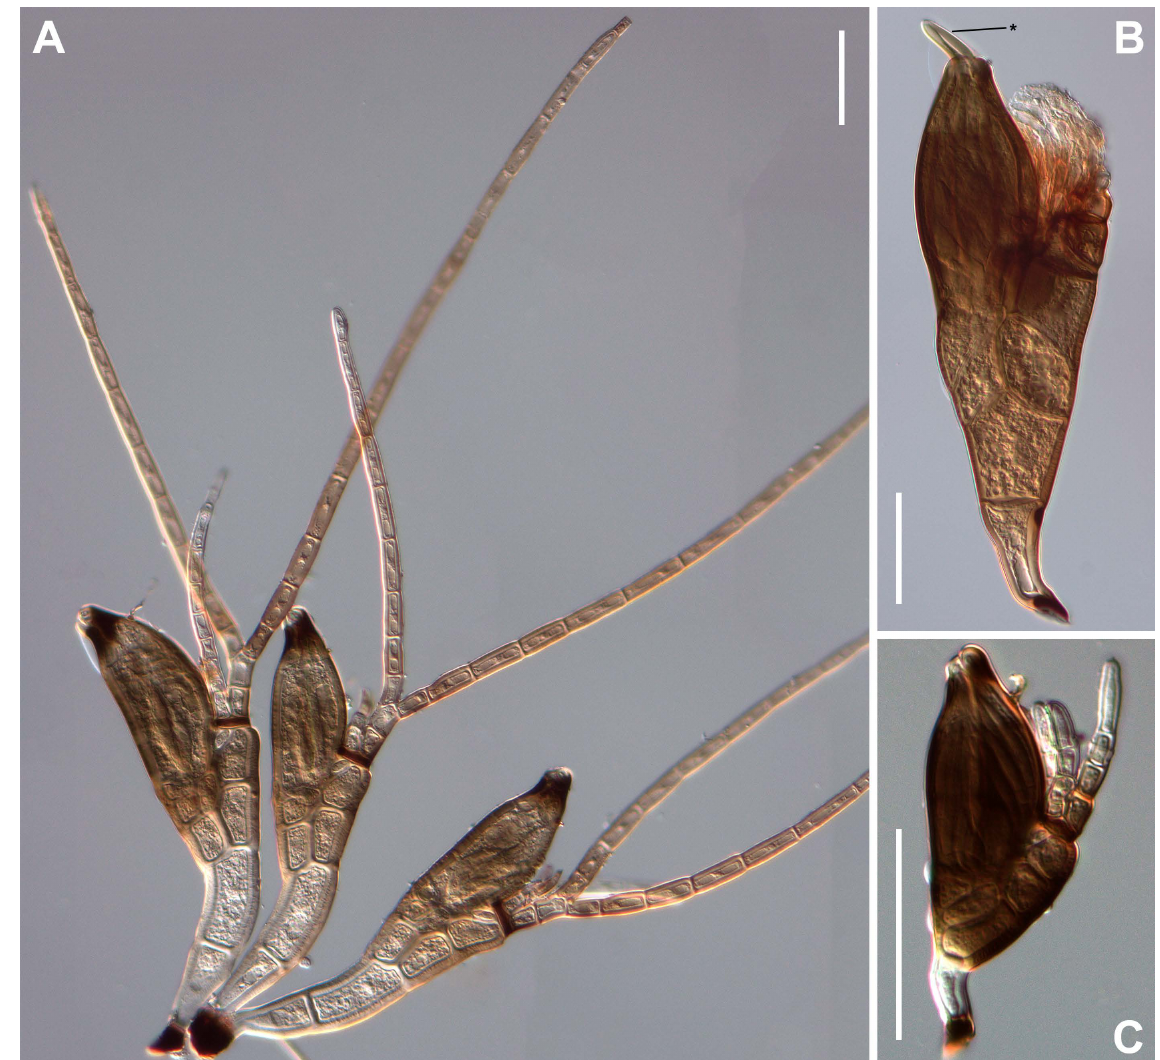
Fig. 28. Laboulbenia spp. A . L. coneglianensis Speg. Three mature thalli. – B . L. cornuta Thaxt. Mature thallus with labelled perithecial protuberance (*). – C . L. corylophi Scheloske. Mature thallus. Scale bars: 50 µm. Photographs from slides ZMUC C-F-123599 (A), ZMUC C-F-123643 (B), ZMUC